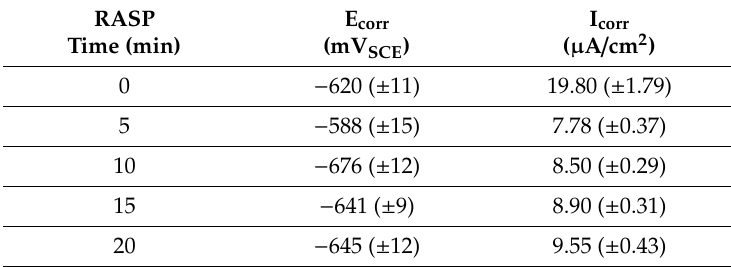
Table 3. Electrochemical parameters of SA106B low-carbon steel for various RASP-processed periods ranging from 0 min to 20 min in the 0.2 M NaCl + 0.05 M Na 2 SO 4